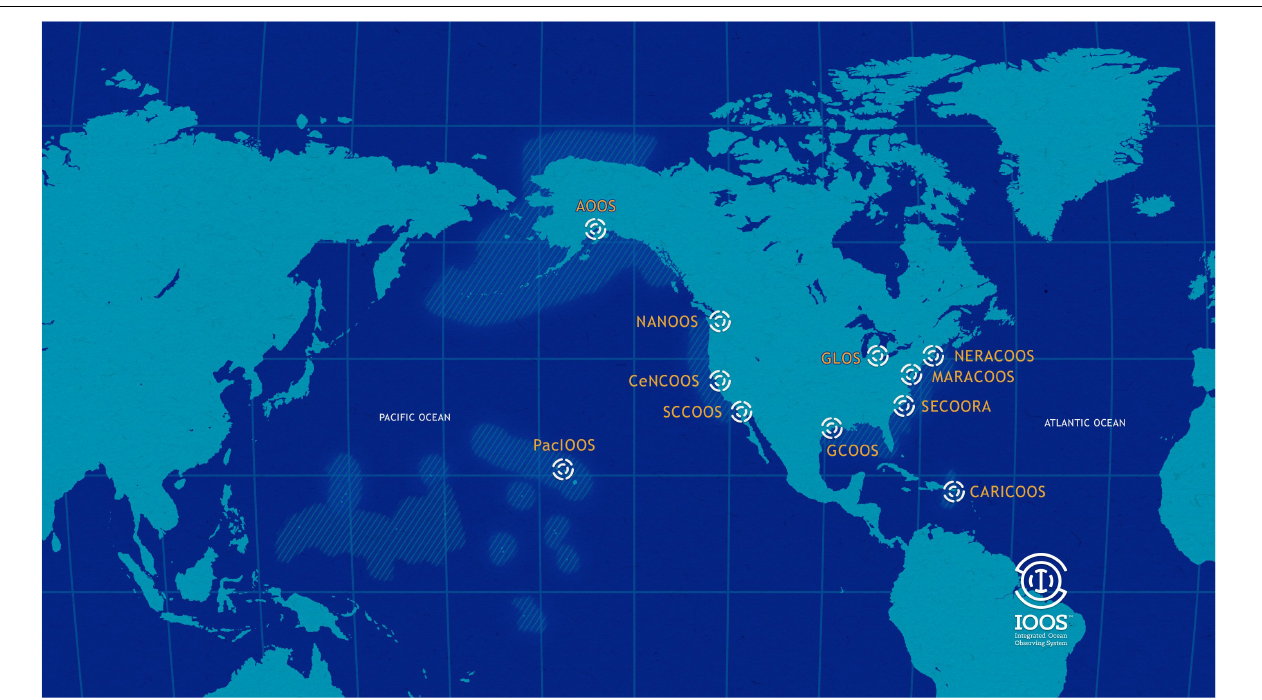
FIGURE 5 | The 11 regional associations spanning the United States coasts, Great Lakes, and Caribbean as established in the Integrated Ocean Observing System (IOOS R (cid:13) ) implementation